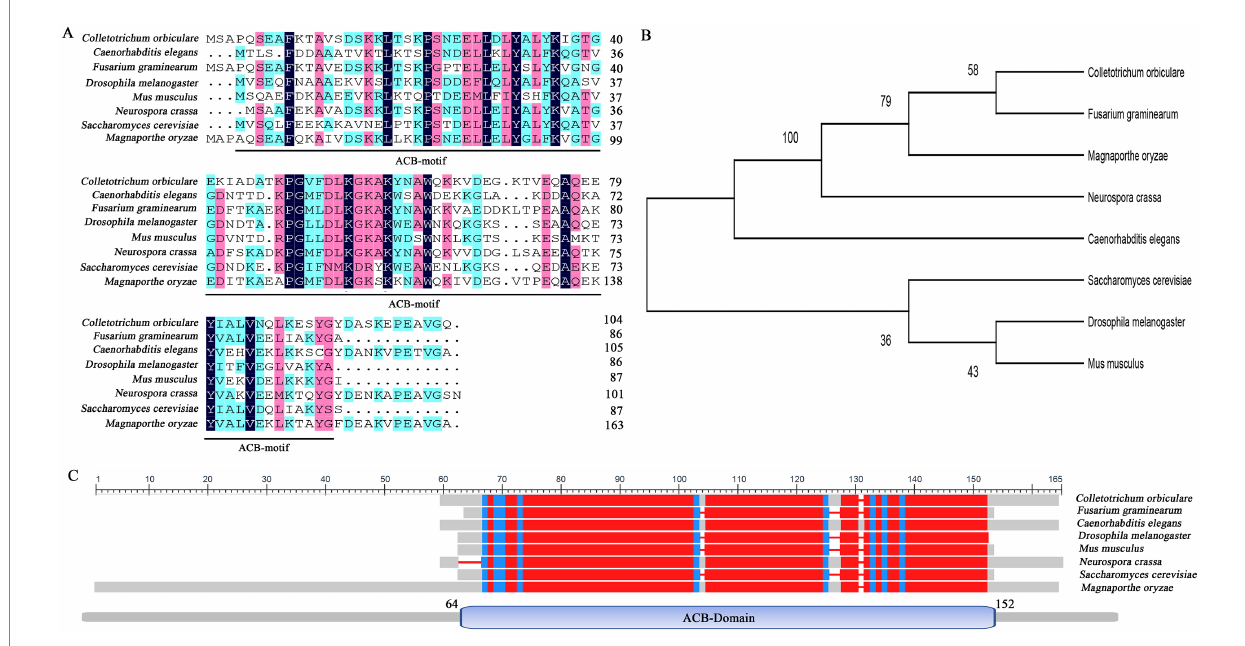
FIGURE 1 Sequence alignment of the amino acids of Acb1 in different species. (A) The amino acids of ACB1 domain were sequence-aligned by DNAMAN 8. Comparative sequences were obtained from Magnaporthe oryzae (MoAcb1), Colletotrichum orbiculare (TDZ22682.1), Caenorhabditis elegans (NP_491412.1), Fusarium graminearum (XP_011327983.1), Drosophila melanogaster (NP_523952.2), Mus musculus (NP_031856.1), Neurospora crassa (XP_962380.1), and Saccharomyces cerevisiae (NP_011551.3). (B) 500 bootstrapped ML (maximum likelihood) tree generated by MEGA v11. (C) The amino acids of Acb1 were sequence-aligned by